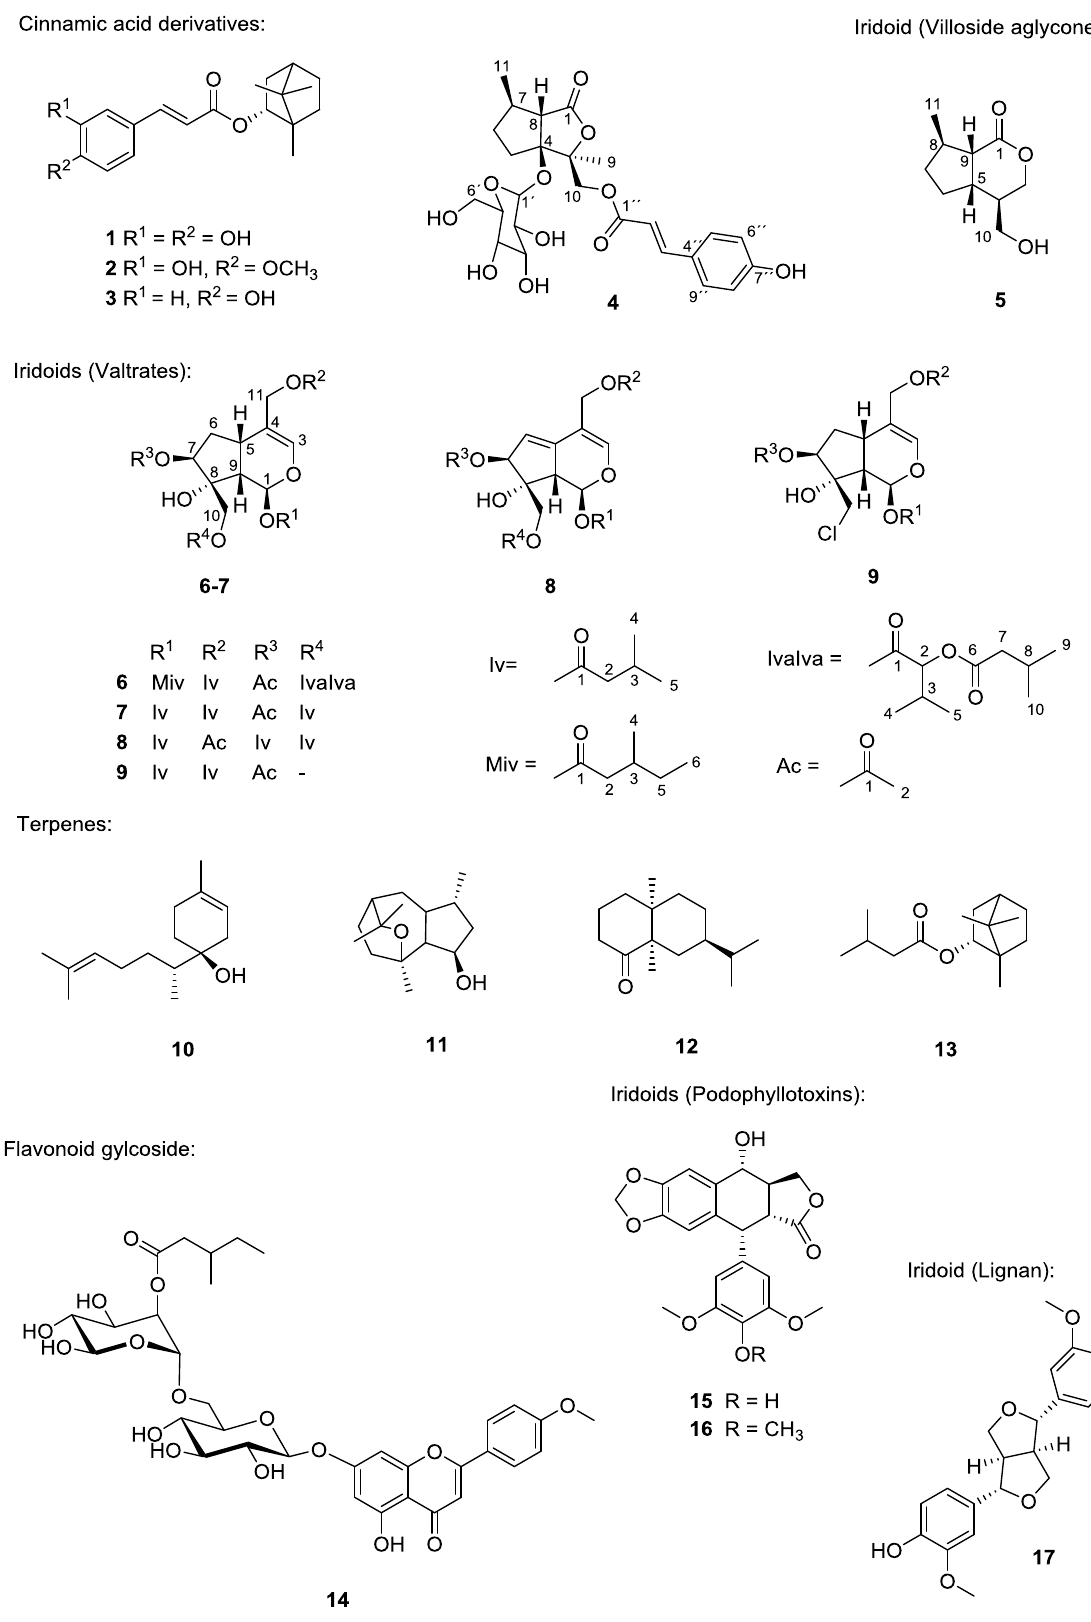
Figure 1. Isolated and identified compounds from V. wallichii extract. Abbr.: Iv = isovaleryl; Miv = β-methylisovaleryl; IvaIva = α-isovaleroyloxyisovaleryl; Ac =